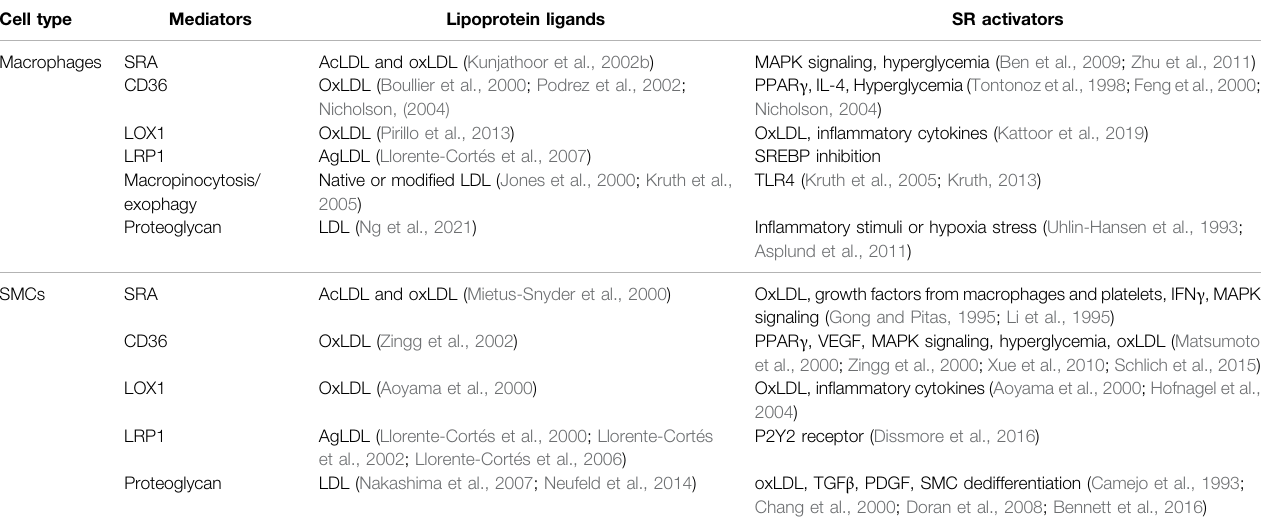
TABLE 1 | Summary of major lipoprotein uptake mediators driving foam cell formation in macrophages and SMCs. Cell